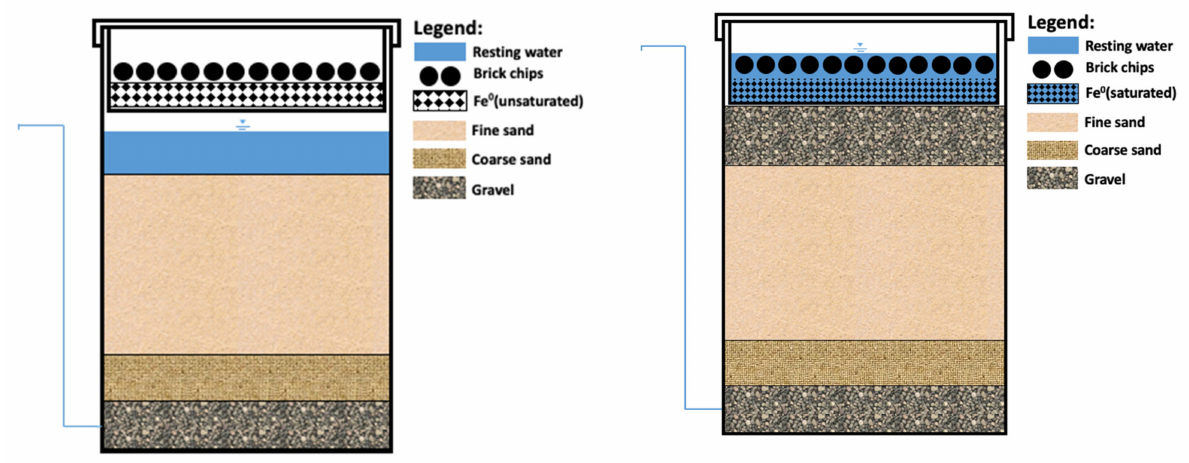
Figure 1. ( left ) Diagram of the original Kanchan arsenic filter (KAF). The location and arrangement of its components are depicted (adapted from [23]). ( right ) Modification of the original KAF to immerse the Fe 0 unit. A gravel layer separates the sand unit from the Fe 0